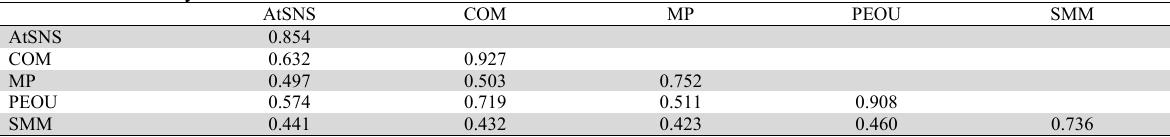
Discriminant validity